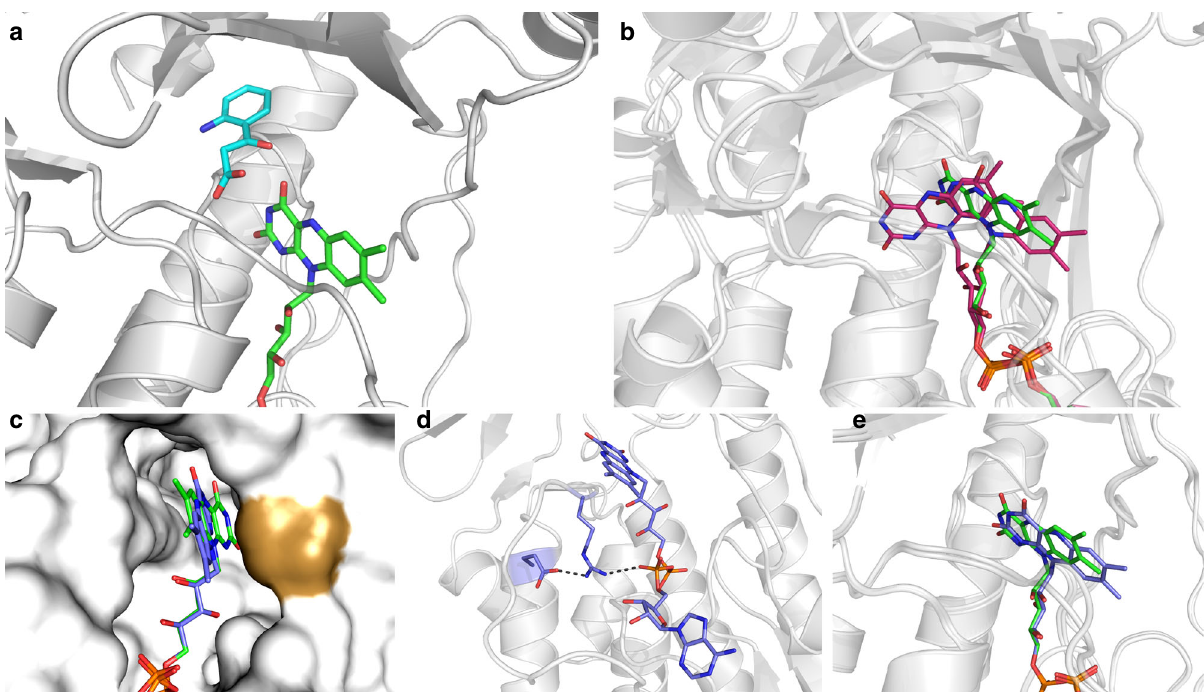
Fig. 3 Crystallographic analysis of FAD and 2-ABA coordination in PqsL. a Unproductive 2-ABA (cyan) binding in PqsL (PDB ID: 6SW1). b Comparison of the fl avin conformation in PqsL (green) to the IN and OUT conformations of FAD in pHBH (red, PDB ID: 1PBB, 1PBE). c Surface representation of the FAD- binding pocket in PqsL. Wild-type (green) and PqsL-Q (blue, PDB ID: 6SW2) FAD conformations are shown in stick representation. Pro273 (golden surface) directly interacts with the fl avin, thereby occluding the fl avin ring and hampering its interaction with NAD(P)H. d Interaction of Arg45 of PqsL-Q with the FAD pyrophosphate moiety. The conformation of Arg45 is further stabilized by hydrogen bonding to Glu106. e Comparison of the FAD conformations in PqsL wild type (green) and PqsL-Q (blue). The fl avin of PqsL-Q is in a more outward position.